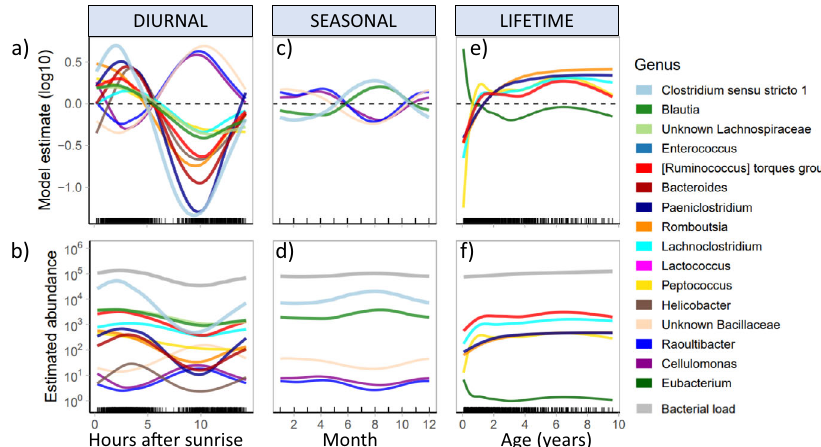
Fig. 4 Temporal dynamics of 16 focus genera across scales. Comparison of temporal dynamics of 16 focus genera across diurnal ( a , b ), seasonal ( c , d ), and lifetime ( e , f ) scales. Top panel shows GAMM abundance estimates across the three temporal scales compared to the mean, where zero (indicated by the dashed line) represents the mean (log10) abundance of each genus. Estimates have been back-transformed in the bottom panel to represent absolute abundance, and bacterial load (grey) is shown for comparison. Only genera that signi fi cantly shift across both frozen and freeze-dried samples are shown (see Supplementary Figs. 6 – 8 for 95% con fi dence intervals and trends split by storage). Source data are provided in the source data fi